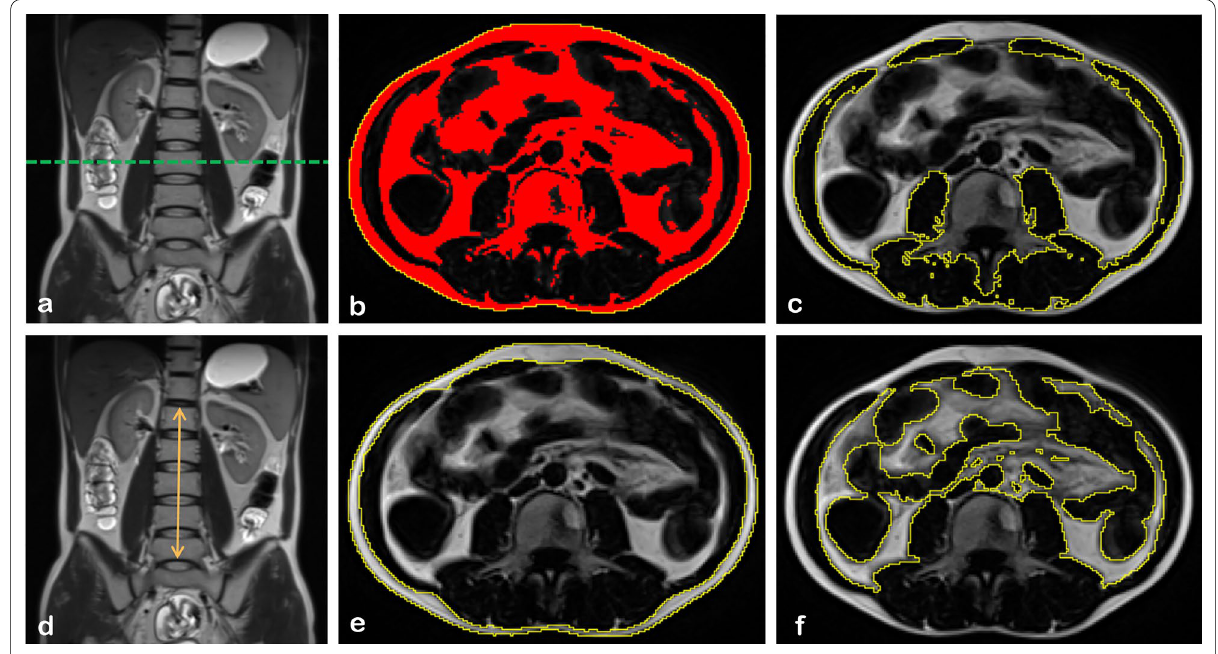
Fig. 1 Extraction diagram of body composition parameters. a Selection of axial L3 level T1WI slice using coronal T2WI as a reference; b mask generated by ImageJ; c region of interest of muscle segmented manually based on a generated mask; d example showing the method to measure the lumbar height; e region of interest of SAT segmented manually based on a generated mask; f region of interest of VAT segmented manually based on the generated mask. SAT: subcutaneous adipose tissue, VAT: visceral adipose